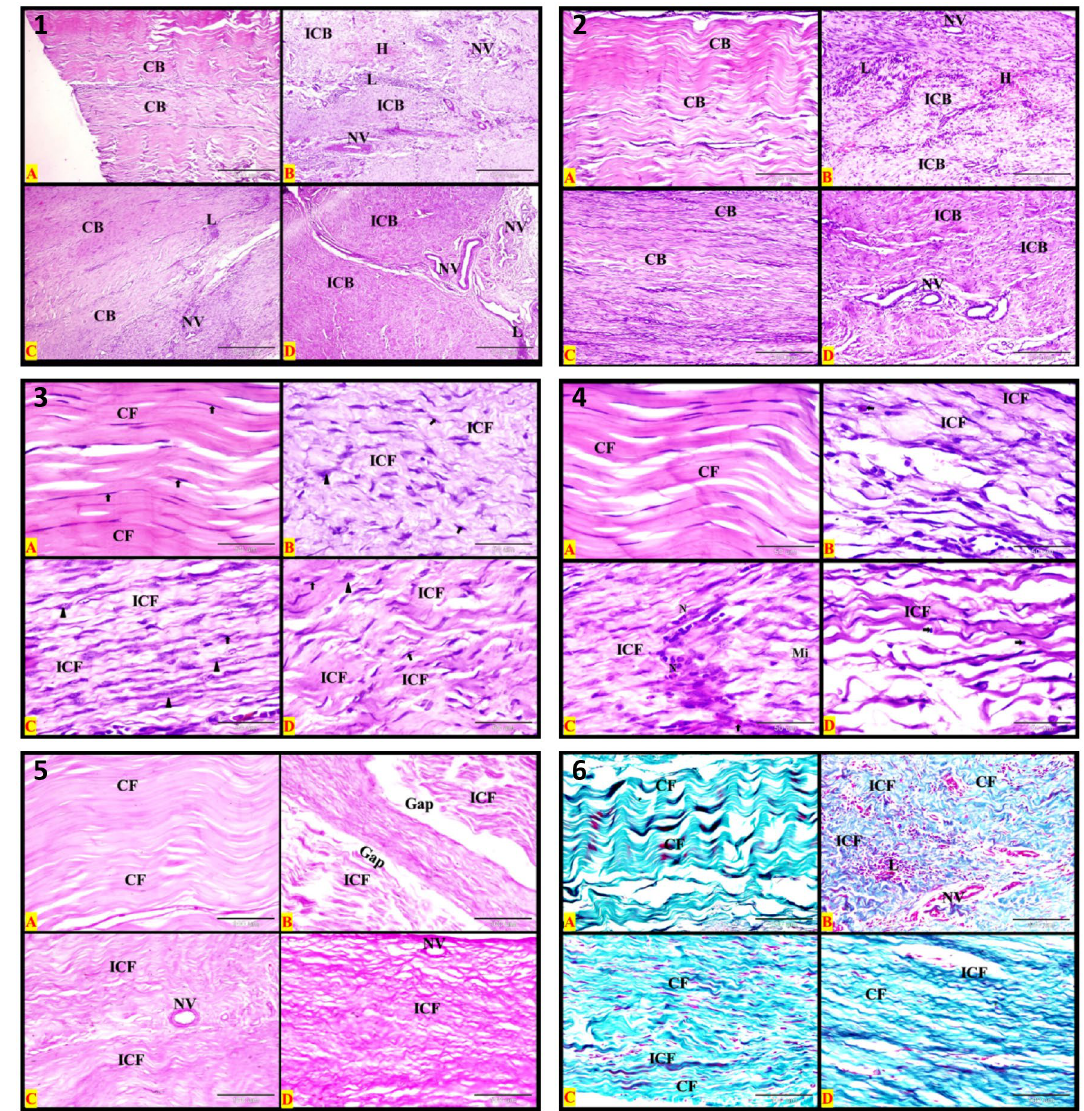
Figure 3. Photomicrograph of longitudinal section from the SDFT at 1 month post-injury. ( A ) Negative control, ( B ) positive control, ( C ) PRF treated, and ( D ) AgNPs treated. Plates (1–4): Haematoxylin and eosin stains, Plate (5): PAS & Haematoxylin, and Plate (6): Crossmon’s trichrome stain. CB regular collagen bundles, ICB irregular bundles, H hemorrhage, L inflammatory leucocytic infiltration, NV neovascularization (new blood vessels formation). All details of figures are displayed in Table 2. Plates 1, 2: Bars = 500 μm (40×); Plates 3, 4, 6: Bars = 50 μm (400×); Plate 5: Bars = 100 μm